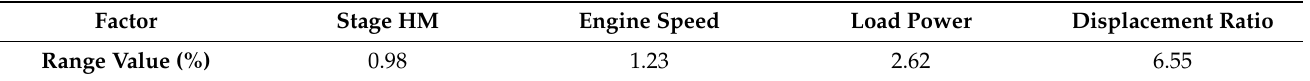
Table 2. Range calculation